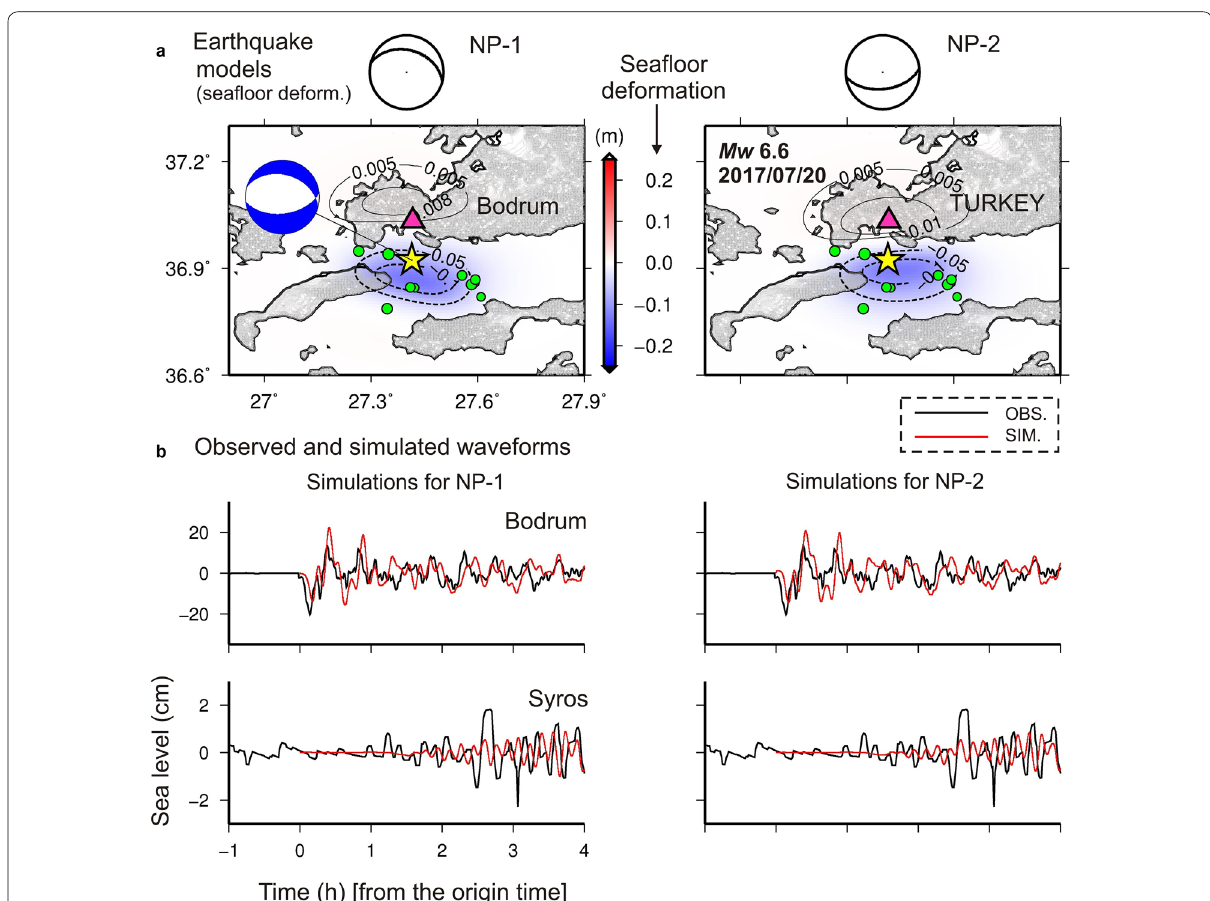
Fig. 4 a Seafloor deformation from source models based on nodal planes 1 (left) and 2 (right) for slip values of 0.4 m for the 20 July 2017 Bodrum– Kos tsunami. Green circles show 1 - day aftershocks ( M 4) from the USGS catalog. b Comparison of observations (black) and simulations (red) for ≥ NP-1 (left) and NP-2